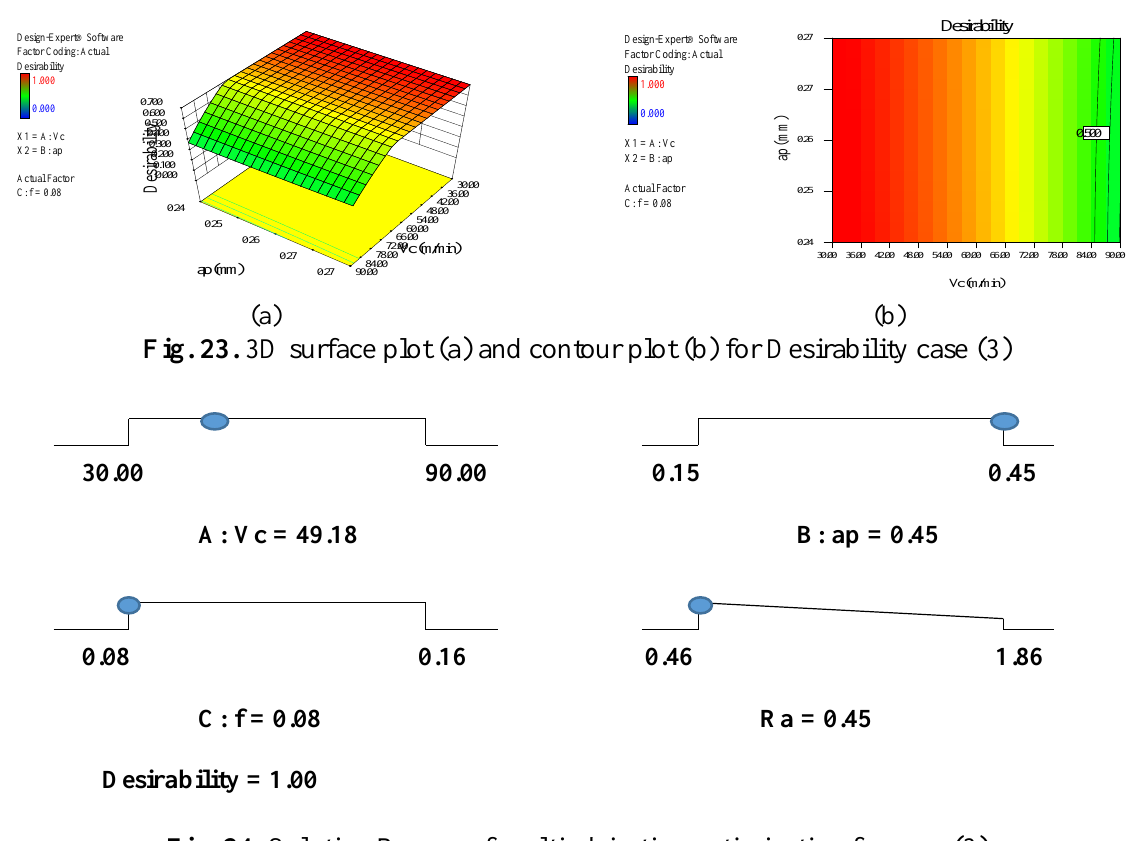
Fig. 24. Solution Ramps of multi-objective optimization for case